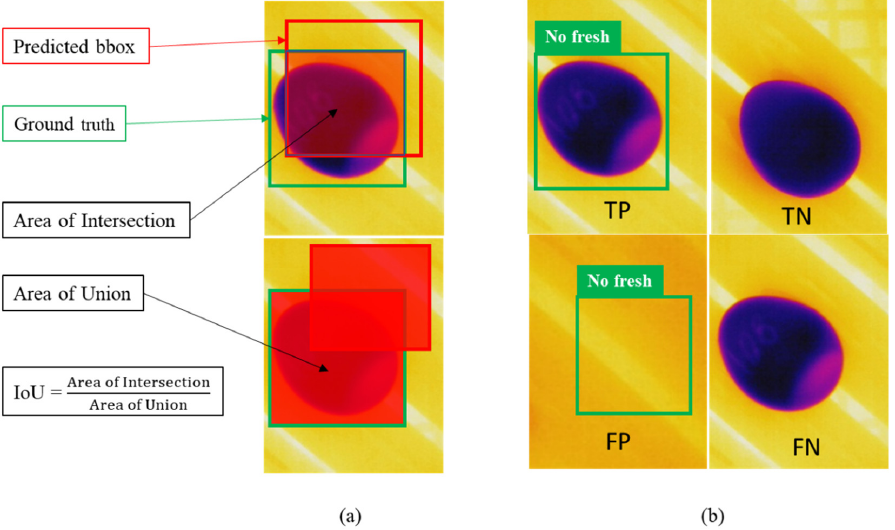
Figure 8. ( a ) IoU demonstrates the relation between the area of intersection and the area of union. ( b ) TP represents correct object detection, TN represents the correct object nondetection, FP is a false detection, and FN is a false negative, representing the case when the object should have been detected but was not.